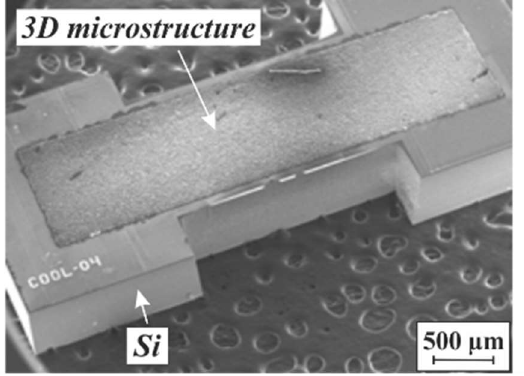
Figure 14. SEM micrograph of a soft magnetic PowderMEMS core for MEMS inductors, agglomerated from Fe particles by 75 nm ALD-Al 2 O 3 at 75 °C. A close-up of an Fe-based microstructure is provided in Figure 10c.